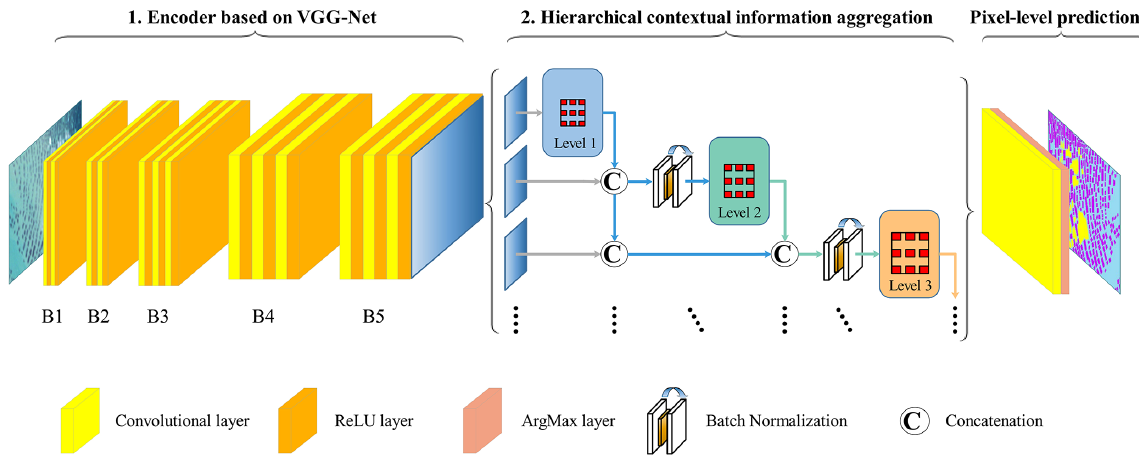
Figure 4. Overview of the proposed HCHNet